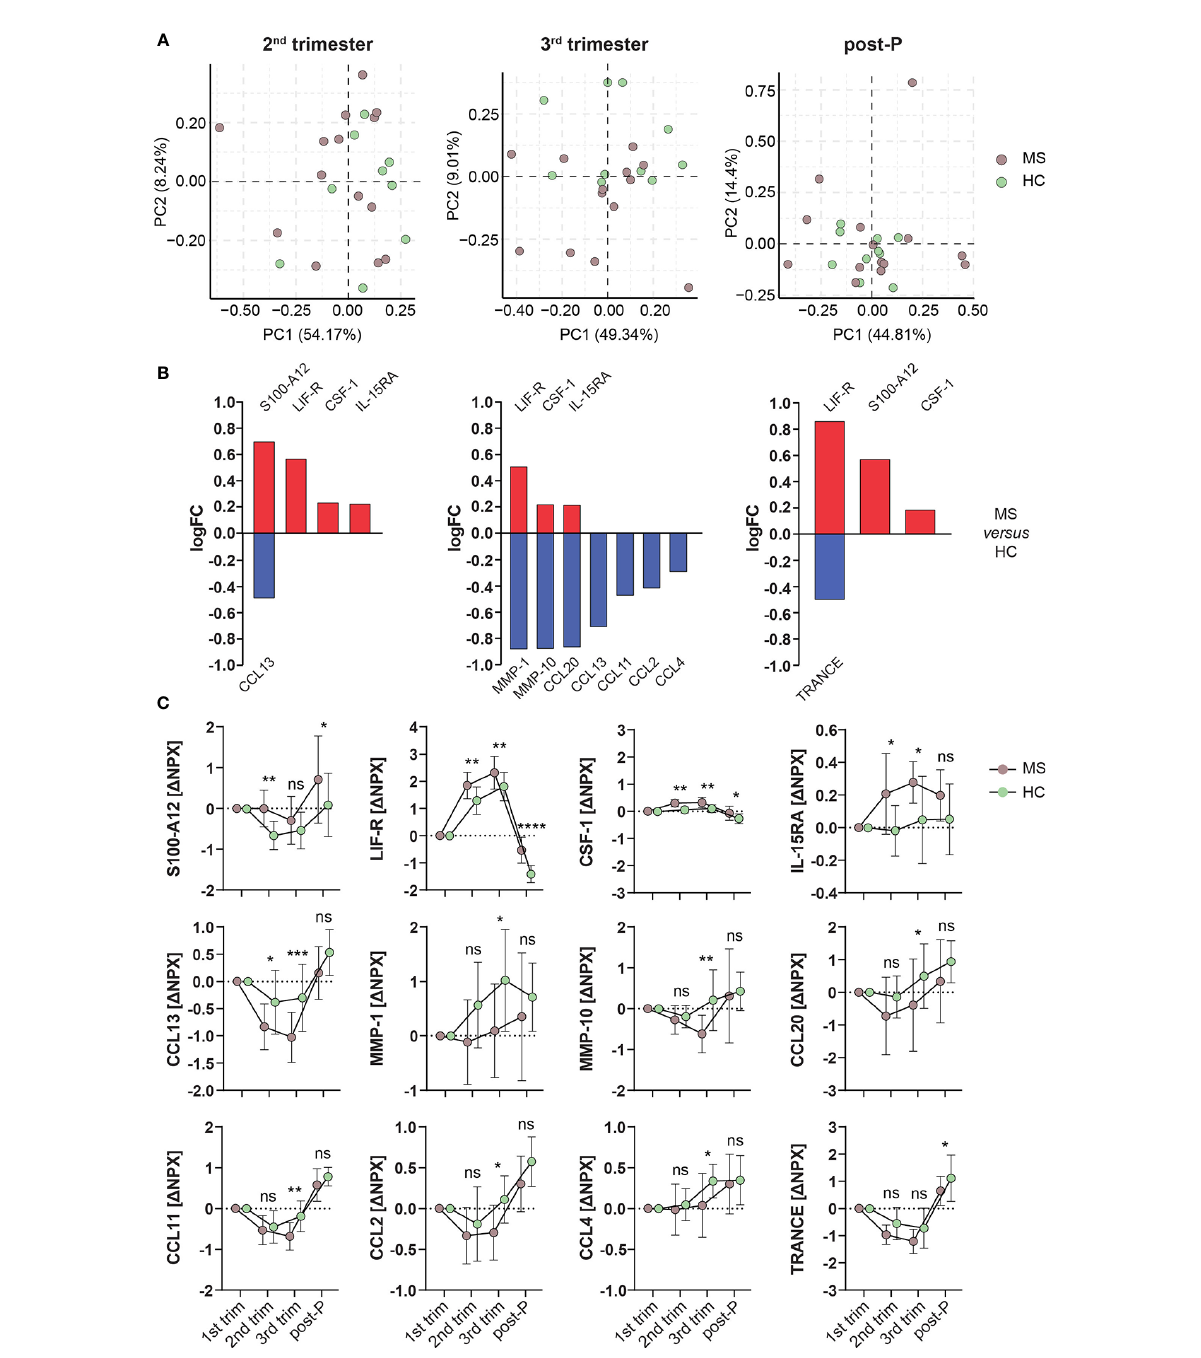
FIGURE 6 Differentially expressed proteins in MS versus HC. (A) Principal component analysis (PCA) plots of protein changes in MS patients and healthy controls (HC) in the different trimesters. PCA was performed on the D NPX values, which were computed by subtraction of the value for the 1 st trimester Brown dots represent MS patients (n = 14, individual 4 in the MS group is excluded due to missing 1st trimester sample) and green dots represent HC (n = 10). (B) Bar graphs showing the nominally differentially expressed proteins (DEPs, p < 0.05) using linear models in MS versus HC. Proteins higher in MS versus HC are shown in red, and the ones lower in MS are shown in blue. (C) Plots of the D NPX values of the nominally DEPs shown in (B) which are higher or lower in MS (n = 14) compared to HC (n = 10). From these proteins, CCL11 and CCL13 in the 3 rd trimester and LIF-R post-partum survived FDR correction. Mean ± standard deviation is shown. *p < 0.05, **p < 0.01, ***p < 0.001, ****p < 0.0001, ns; not signi fi cant. HC, healthy controls; logFC, logFoldChange; MS, multiple sclerosis; NPX, normalized protein eXpression; PC, principal component; post-P, post-partum; trim,